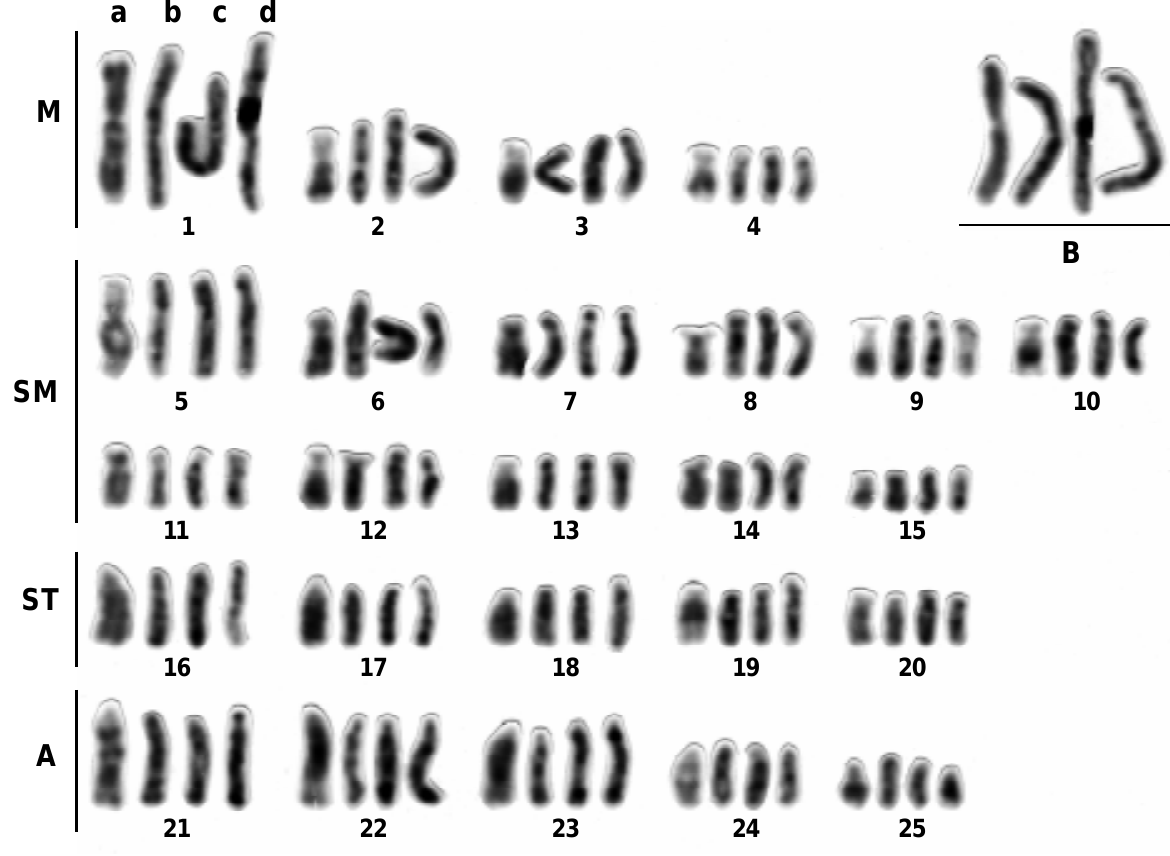
Figure 2 - Haploid chromosome sets of Astyanax scabripinnis paranae showing different patterns of longitudinal differentiation after being submitted to banding procedures: (a) R-banding; (b) G-banding with trypsin; (c) G-banding after treatment with RE Bam HI, and (d) almost similar G-banding patterns obtained with RE Hin fI. B, B-chromosomes. M, Metacentric; SM, submetacentric; ST, subtelocentric; A,